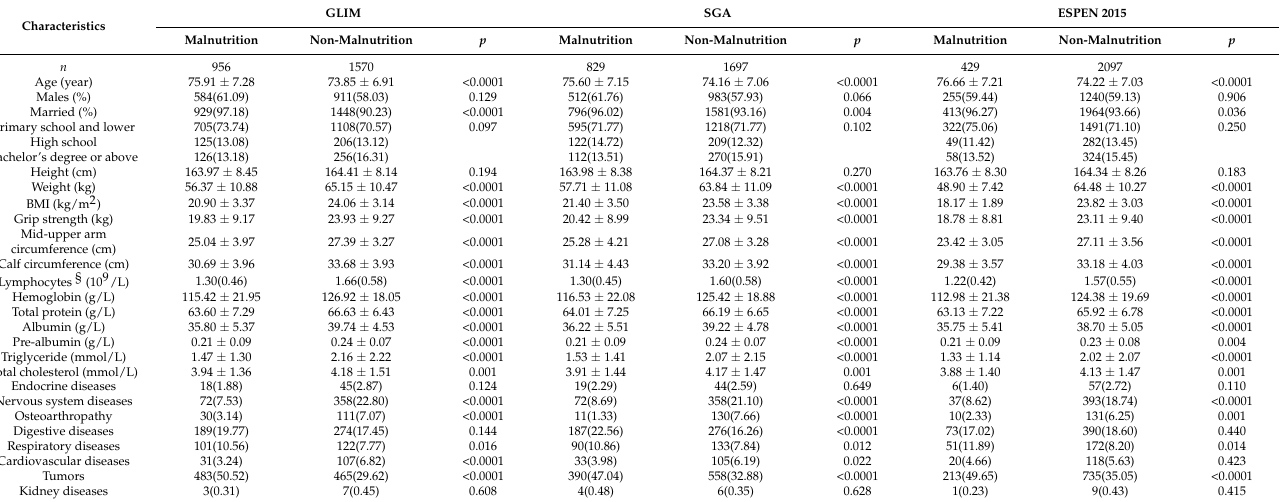
Table 1. Comparison of the demographic characteristics, anthropometric parameters, blood pa- rameters, and reasons for hospitalization between malnourished and non-malnourished subjects diagnosed with the GLIM, SGA, and ESPEN 2015 criteria,